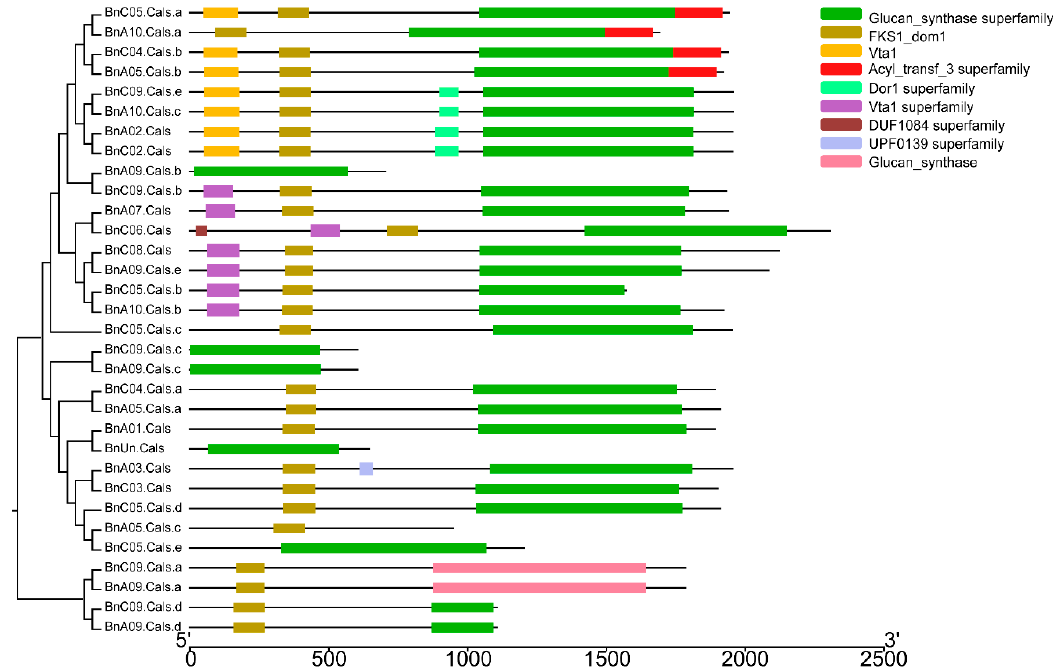
Figure 6. Schematic representation of the conserved domains in the BnCalS genes. Each predicted domain is represented by a colored box indicated at the right side.